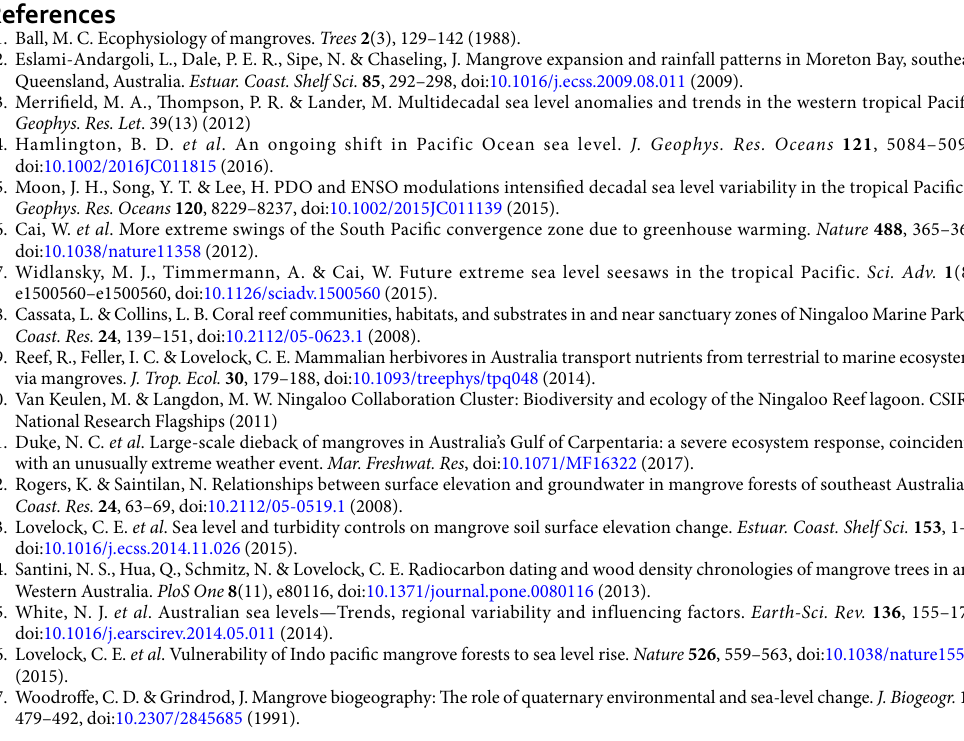
7 Scientific RepoRts | 7: 1680 | DOI:10.1038/s41598-017-01927-6